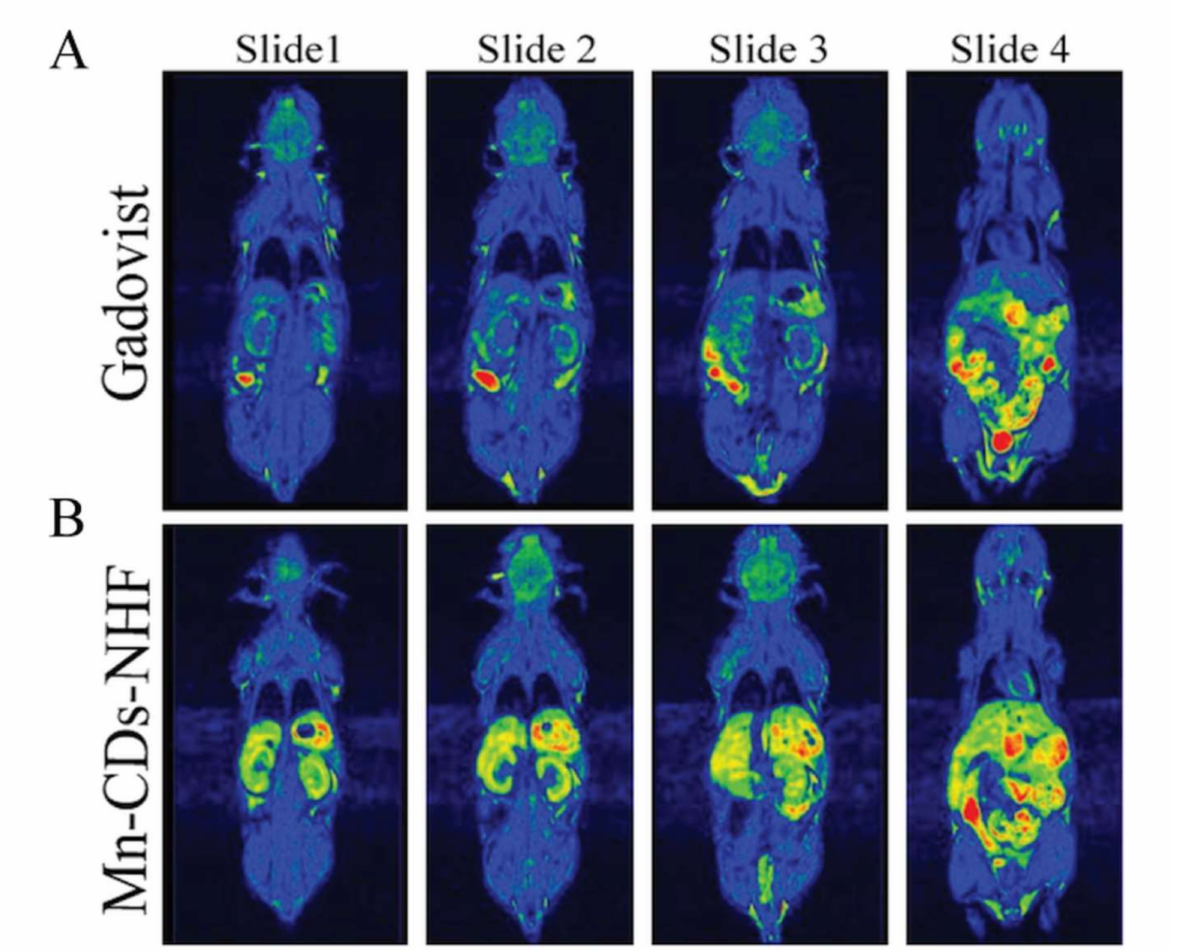
Figure 3. MRI comparative images of healthy mice highlighting the ability of the new compound, Mn-CDs-NHF as an MRI contrast agent ( B ) as compared to Gadovist, which is a commercial MRI contrast agent ( A ). Images are obtained using the same sequences, which were performed at 2 h after i.p.